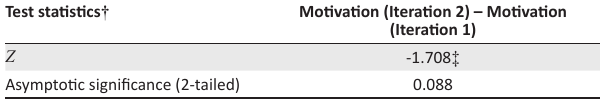
TABLE 6 : Test statistics for the motivation sub-scale.